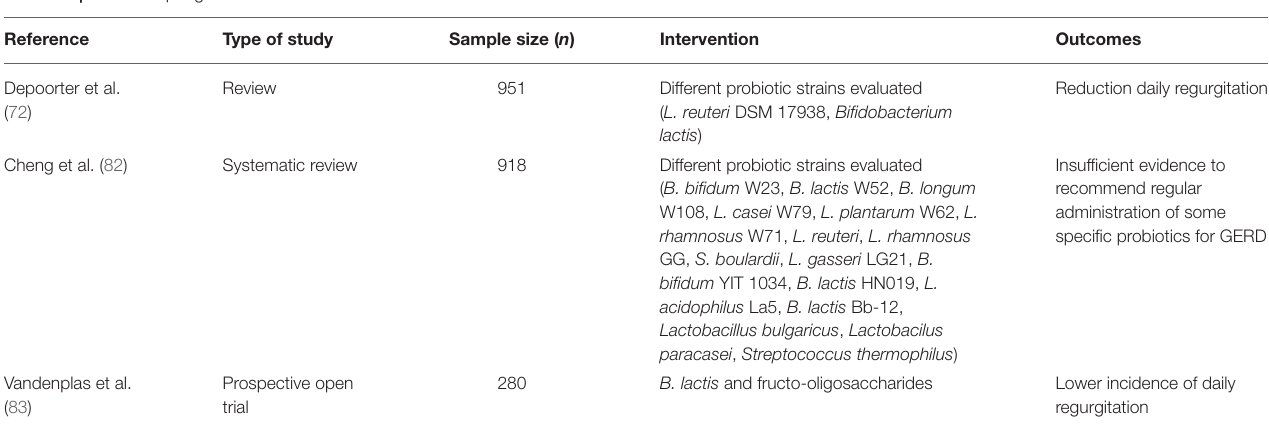
TABLE 4 | Gastroesophageal